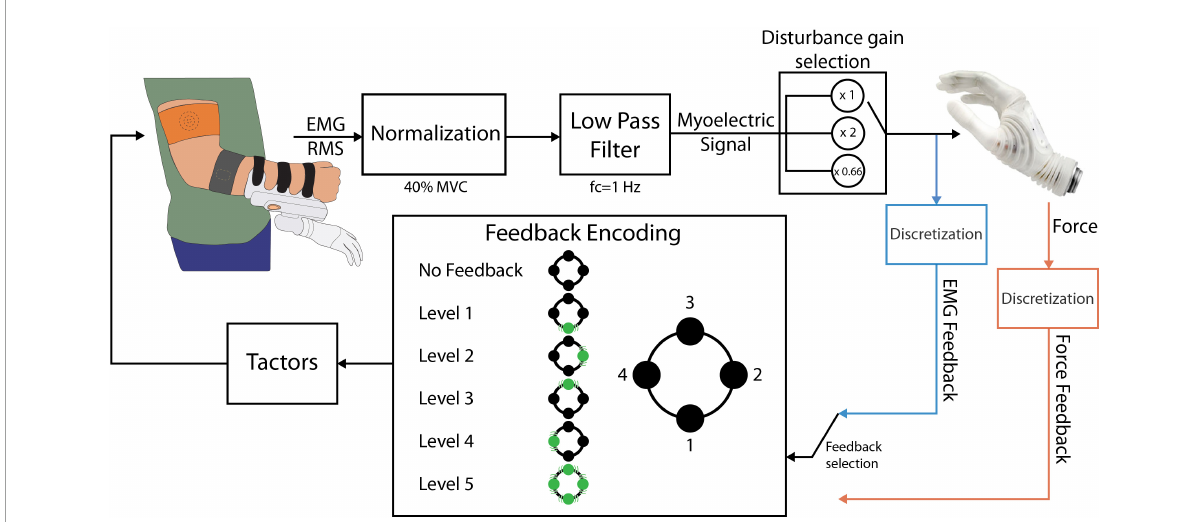
FIGURE2 The closed-loop prosthesis control scheme. The electrodes outputted the RMS of the EMG, which was low-pass filtered and normalized to 40% of the MVC, resulting in the myoelectric (ME) control signal. The ME signal was sent to the prosthesis as a closing velocity or opening command. If EMG feedback was used, the ME signal was discretized into levels and conveyed back to the subject through the tactors. If force feedback was used, the force was discretized and fed back to the subject using the same encoding. The position and numbering of the tactors in this diagram is consistent with the one shown in Figure 1